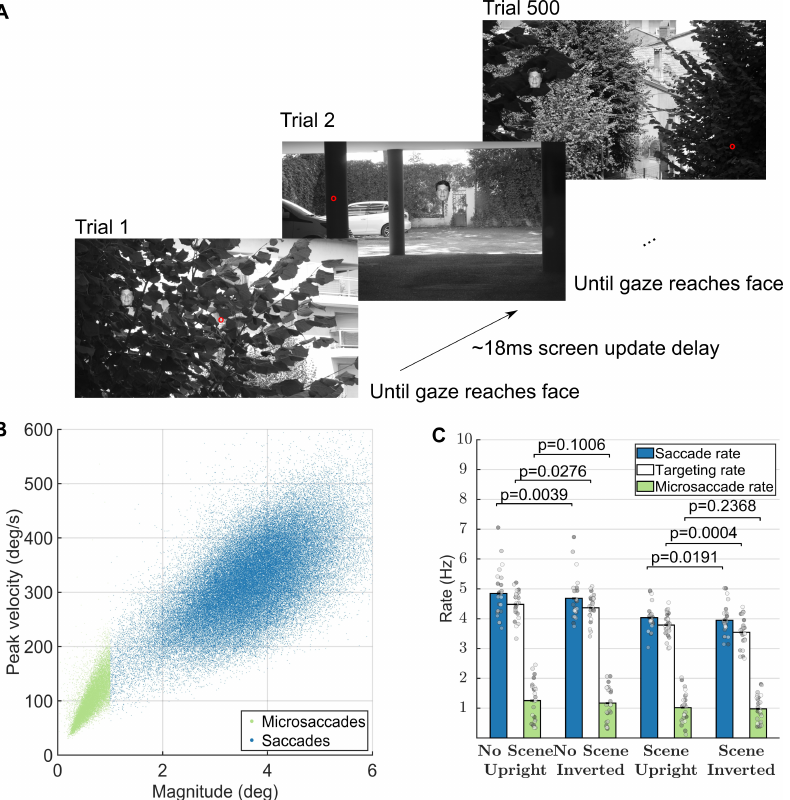
Figure 1. Task, presentation, and saccade analyses. (A) Task (reproduced from Martin et al. 2018). Red dot represents a hypothet- ical gaze location. The face shown is only for illustration, as we actually used 500 different faces in each block of 500 trials. (B) Main sequence of peak velocity versus magnitude for microsaccades (red dots) and saccades (blue dots). (C) Average subject- specific saccade, targeting, and microsaccade rates calculated within the -200ms to 800ms interval of each trial. Error bars corre- spond to the 95% confidence intervals around the mean. Figure 1A is an unmodified reproduction from the source’s Fig 1A (Martin et al.,